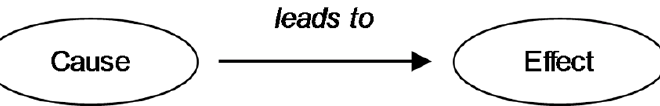
Figure 13. Causal structure (adapted from [177] ).